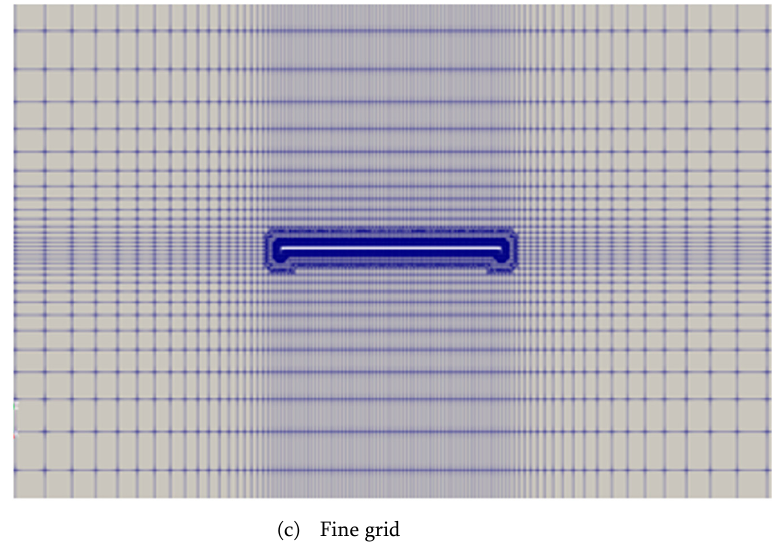
Figure 8. Three grids for uncertainty assessment. Table 2. Grid number for uncertainty assessment.